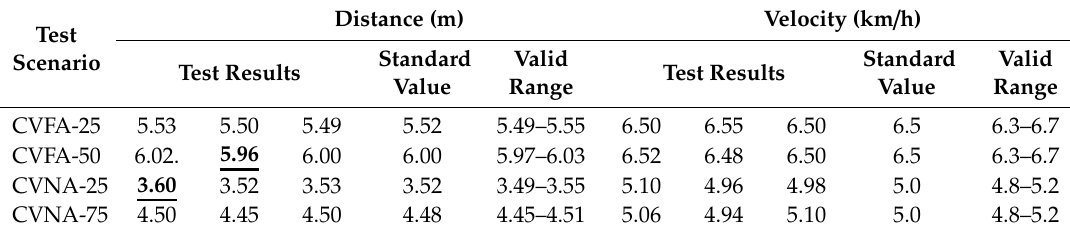
Figure 14. Test the control accuracy of the dummy target traction system for the speed of the dummy target. Table 4. Test of the walking distance and speed of the dummy target (with